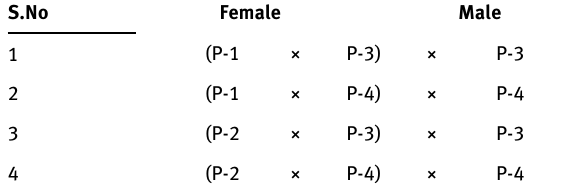
Grains from 10 randomly selected ears of each treatment were shelled after drying and then shelling percentage was calculated according to John